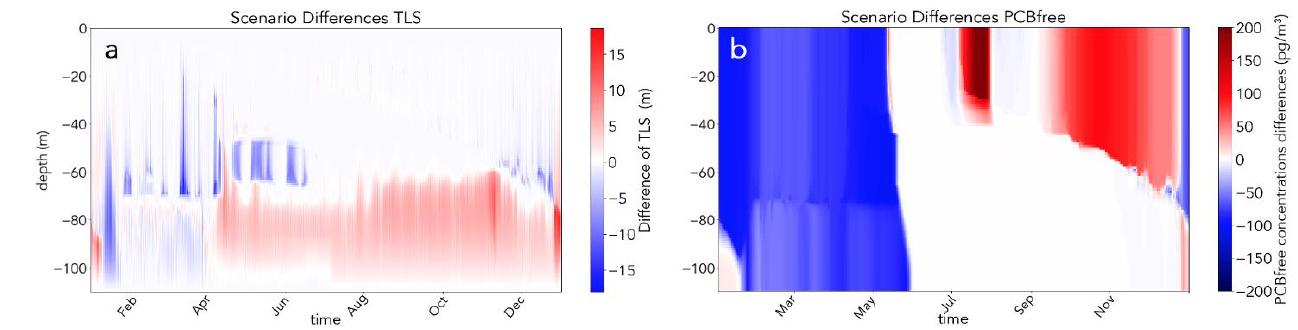
Figure 11. Differences between tide – no-tide scenarios for NNS region: ( a ) in turbulence length scale; ( b ) in PCB free concentration.